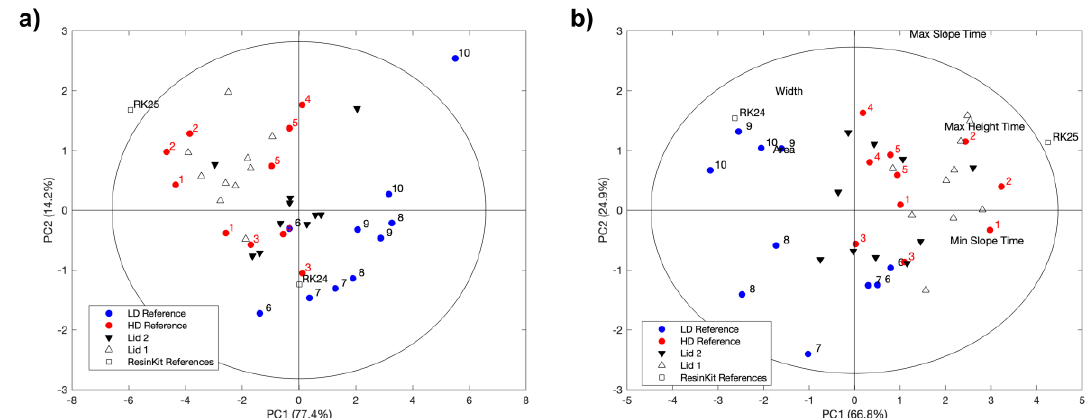
3 Figure 3. PCA for normalized EGA curves (Method A) ( a ) and curve parameters (Method B) ( b ). Two replicates for each irradiation time were considered, numbered for LDPE and HDPE references, unnumbered for lid 1 and lid 2. Projection of ResinKit TM No. 24 and 25 is also